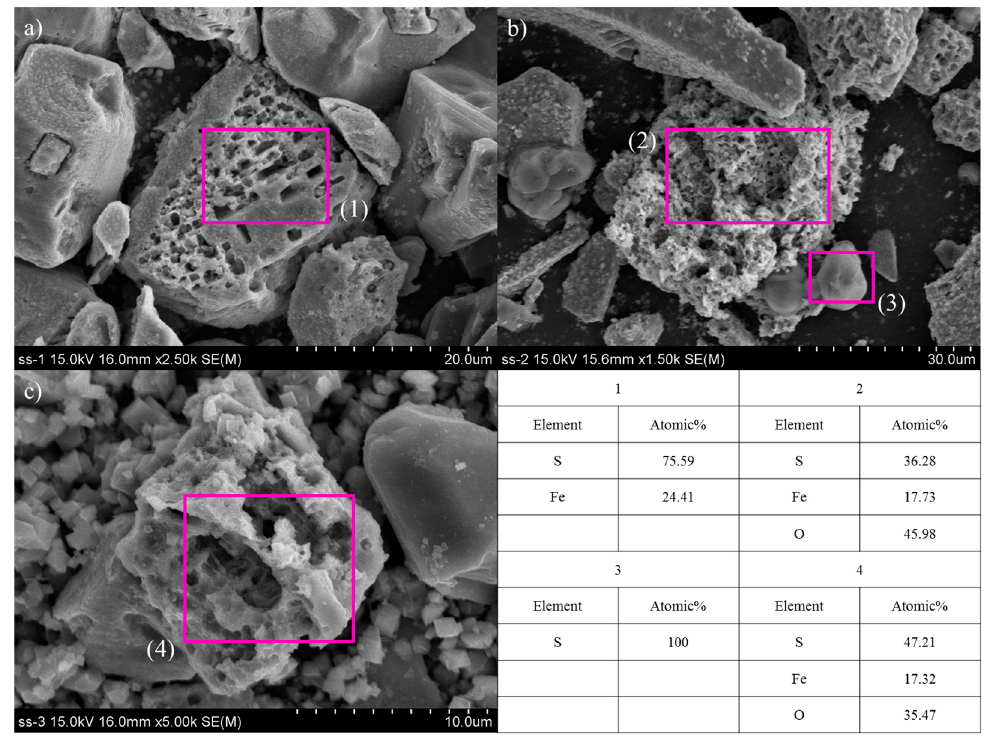
Figure 16. SEM images of the leach residues from nitric acid leaching at (a) 1.0 M, (b) 3.0 M and (c) 5.0 M. The leaching time was 15 min.